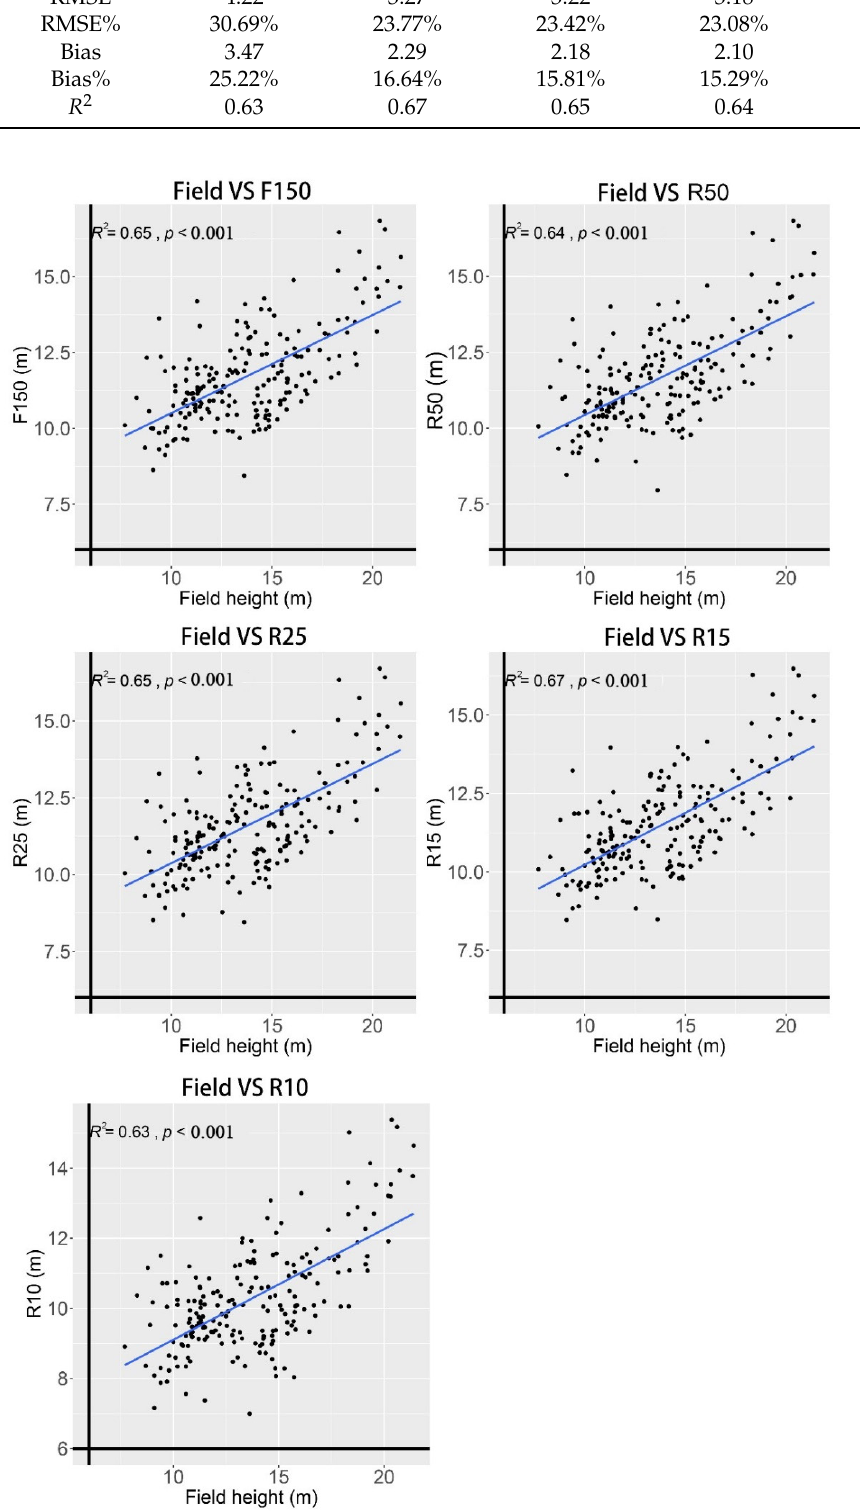
Figure 4. Regression analysis comparing the height of D. pierrei obtained using different point cloud densities and the height of D. pierrei obtained from the ground survey.